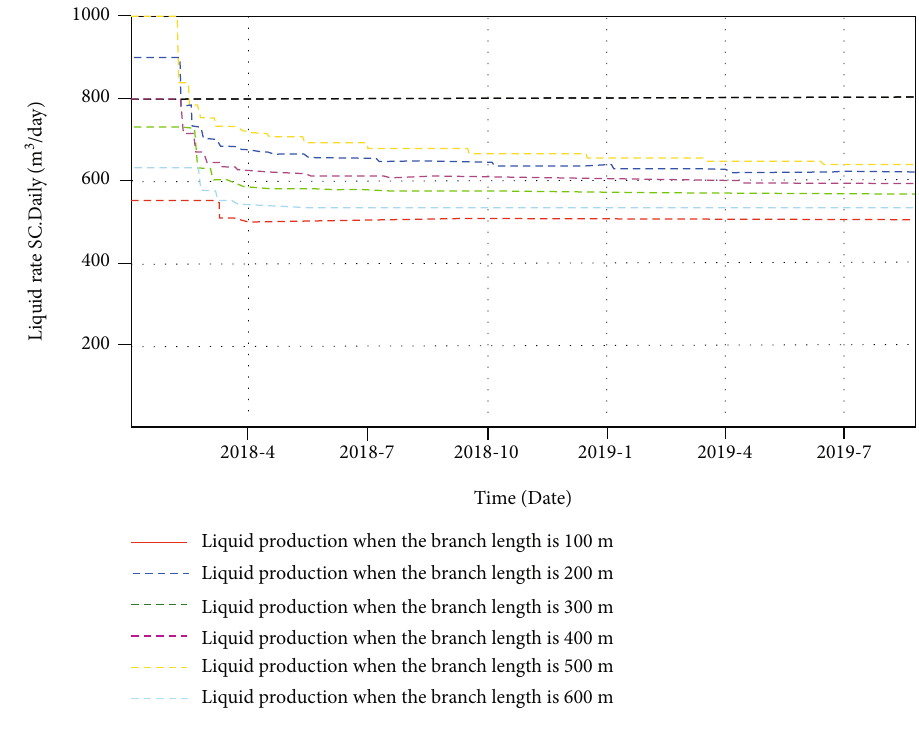
Figure 19: Production with di ff erent branch lengths.